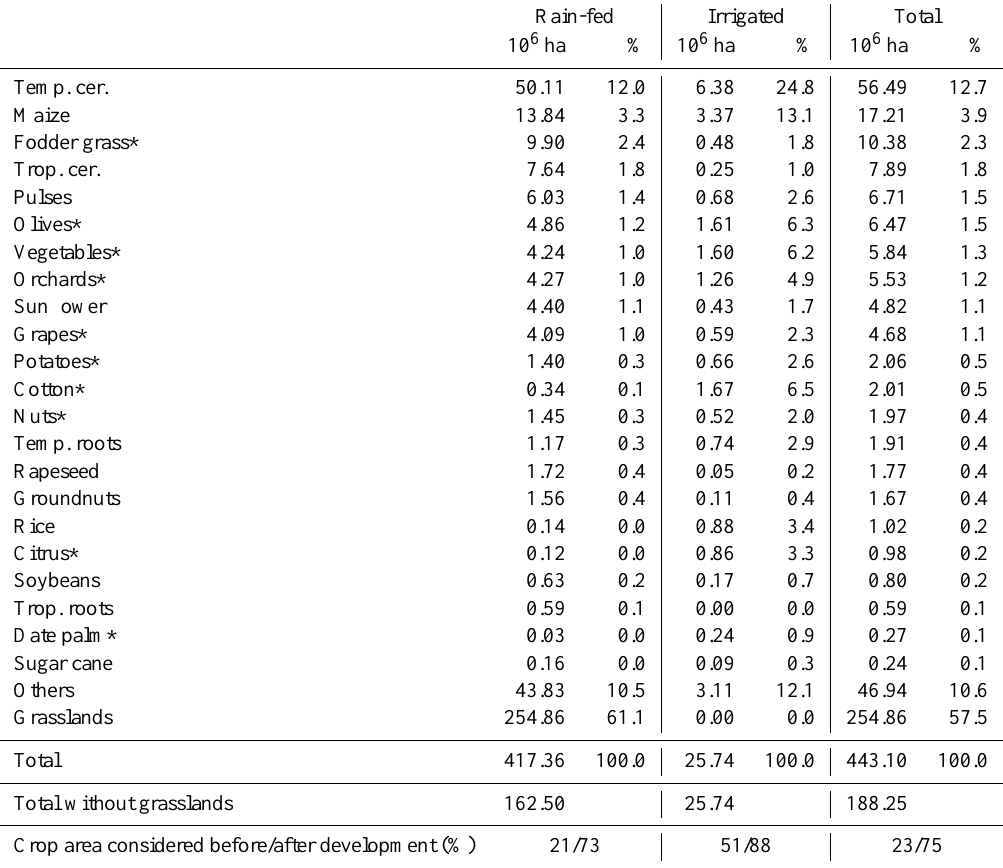
Table 1. Areas of LPJmL crops in the Mediterranean region. The stars indicate crops that are implemented in this study. Rain-fed Irrigated Total Temp.